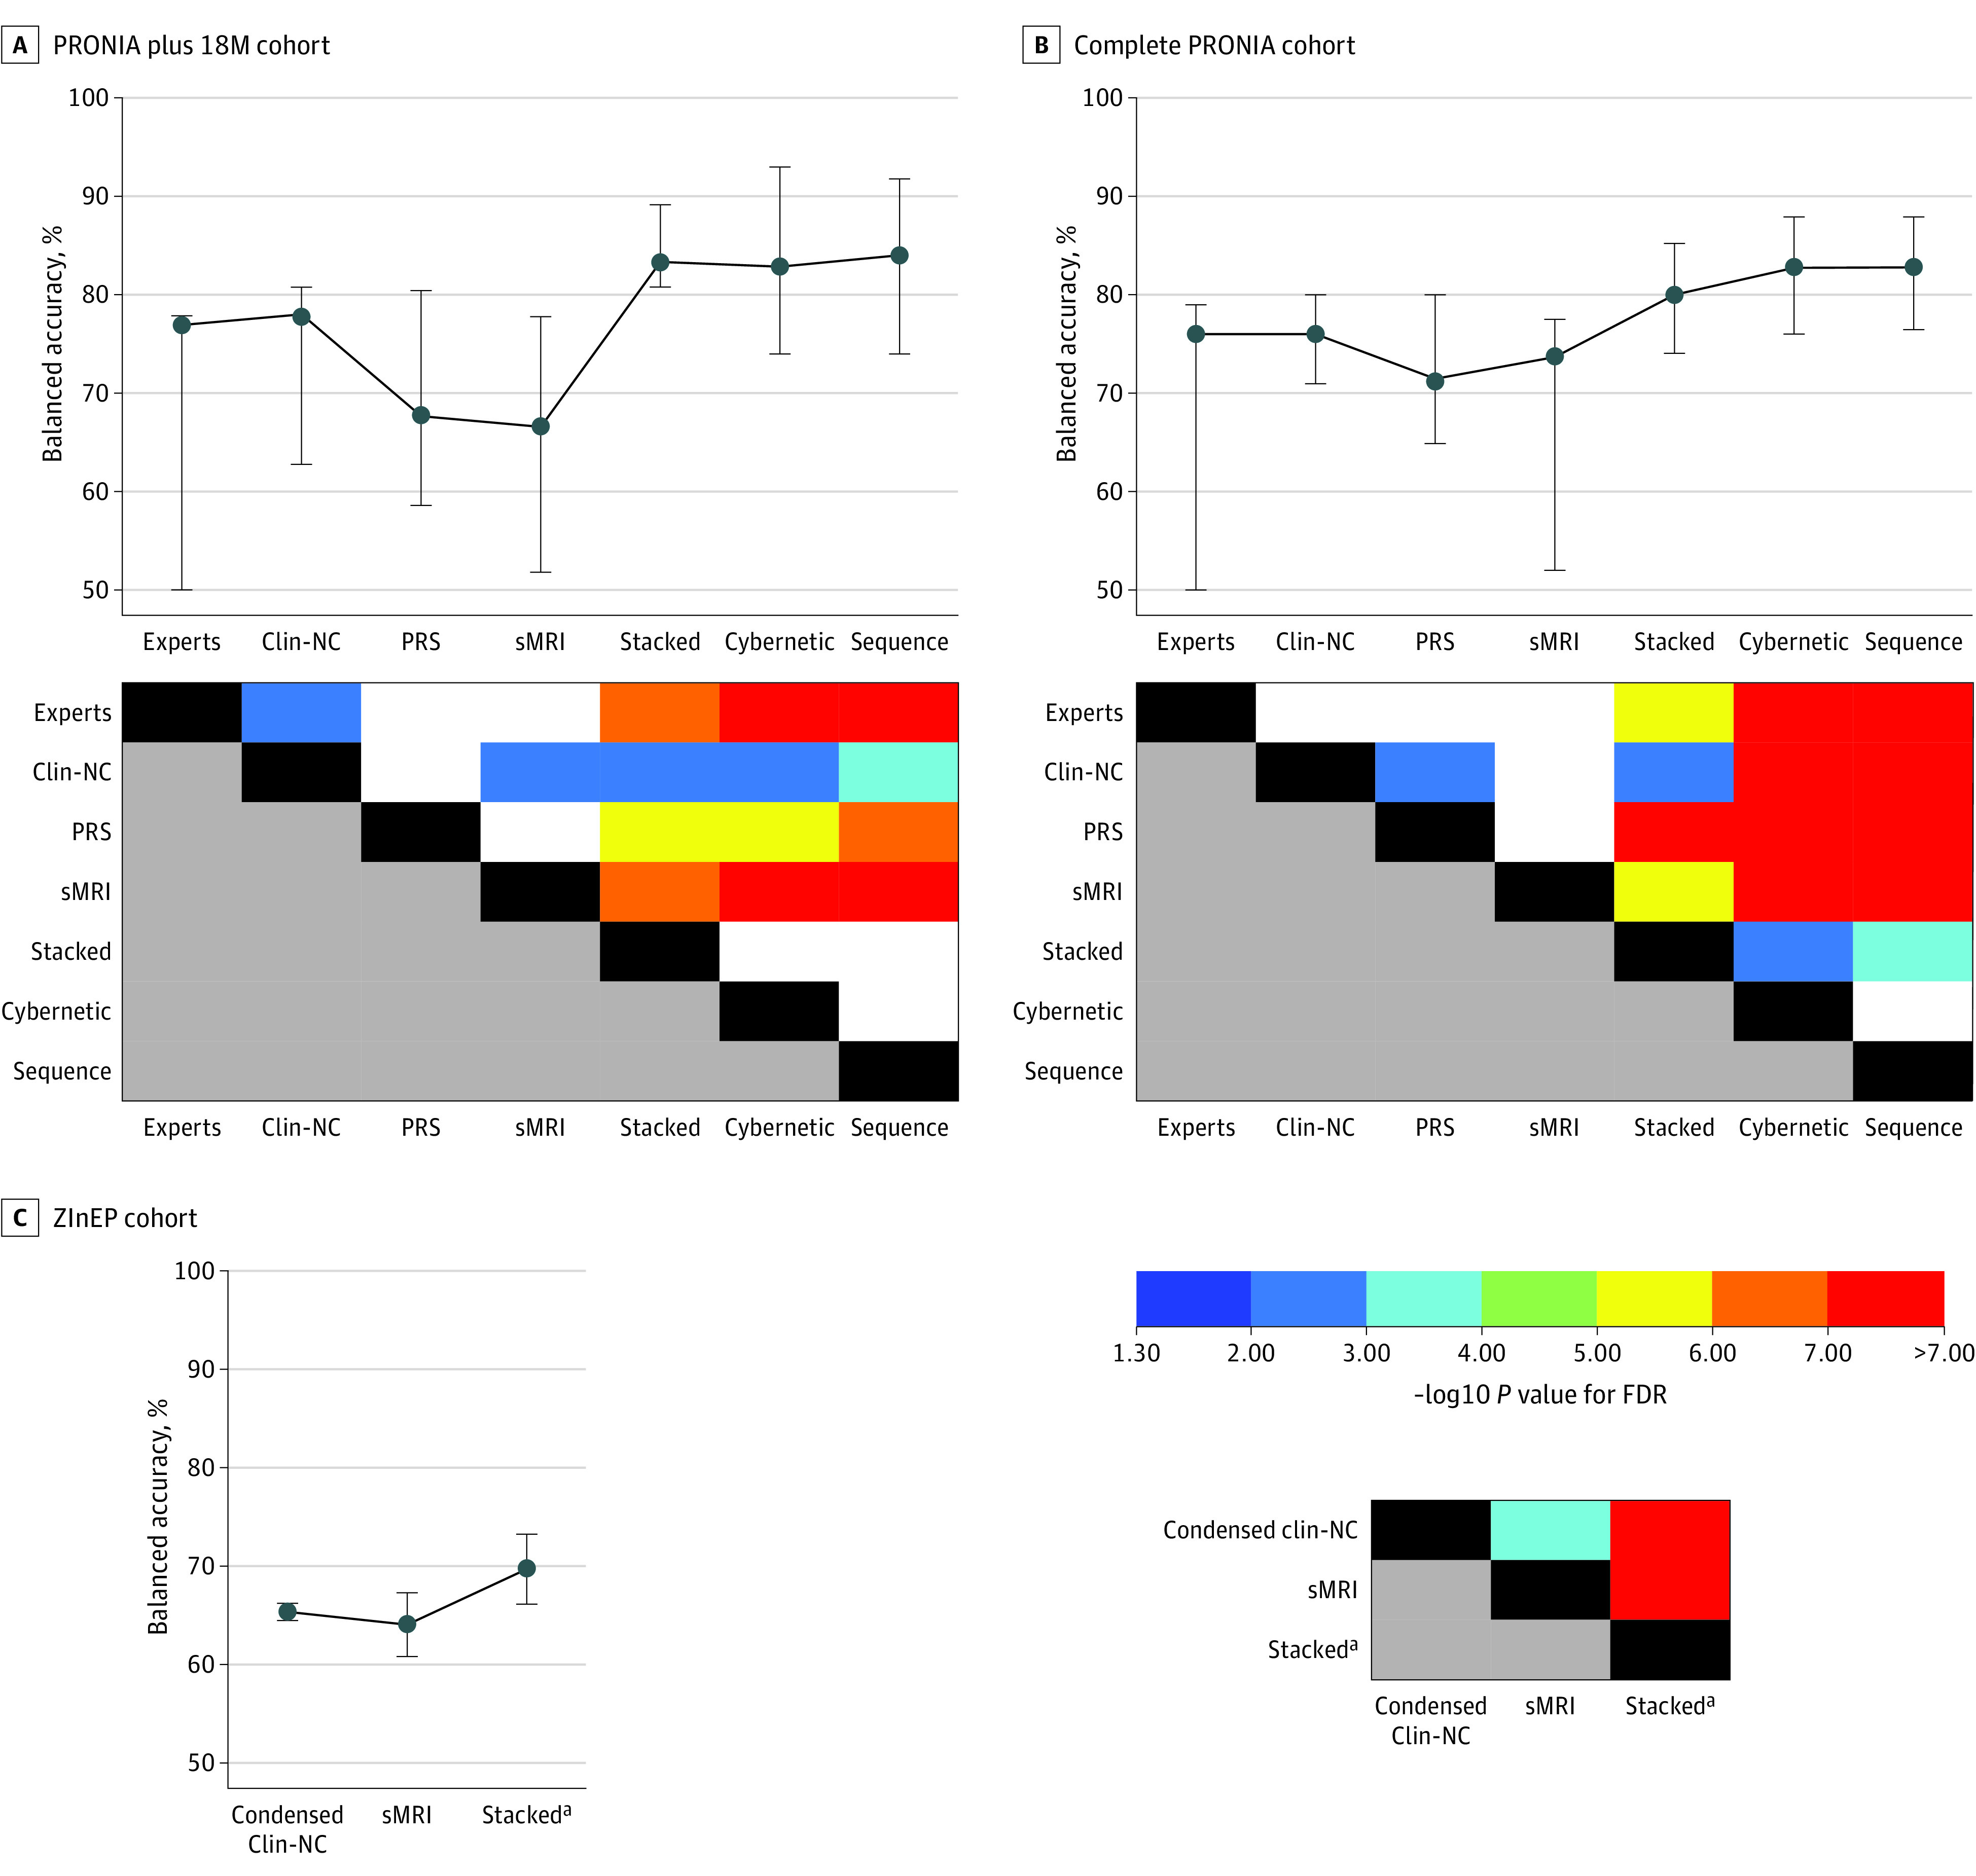
Statistical Comparison of Prognostic Models Cohorts include patients with follow-up of 18 months or longer (PRONIA plus 18M), the complete PRONIA cohort, and the Zurich Early Recognition Program (ZInEP). Data points indicate median. The Quade test51 was used to compare the models’ median balanced accuracy (BAC) computed across the cross-validation cycle (CV2) test data partitions. The BAC measures obtained for the ZInEP cohort (C) were produced by applying the condensed clinical-neurocognitive (Clin-NC), structural magnetic resonance imaging (sMRI)–based, and respective stacked risk calculators of the complete PRONIA sample (B) to this external sample (eFigure 2 in the Supplement). Post hoc comparisons were performed using the t distribution approximation described by Heckert and Filliben.52
P values were corrected for multiple comparisons using the false discovery rate (FDR). The upper graphs represent the median BAC for each risk calculator in analyses A, B, and C along with the lower and upper quartiles of the BAC distributions (whiskers of the error bars). The lower figures show the logarithmized, FDR-corrected P matrix for the pairwise post hoc classifier comparisons. For an in-depth analysis of the prognostic sequence included in the risk classifier comparison, see eFigures 14 and 15 in the Supplement. The cybernetic risk calculator analyzed the combined predictions of raters, Clin-NC, polygenic risk score (PRS)–based, and sMRI-based risk calculators; the stacked risk calculator, the combined predictions of Clin-NC, PRS-based, and sMRI-based risk calculators.aIndicates risk calculator encompassing the condensed Clin-NCs and sMRI-based models and specifically trained to externally validate the effect of stacking on prognostic performance in the ZInEP cohort.